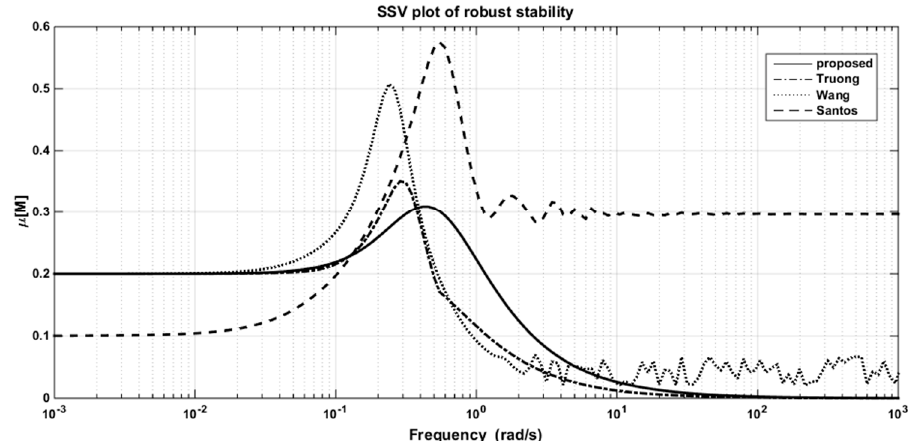
Figure 12. The SSV plots for robust stability in the WB column.